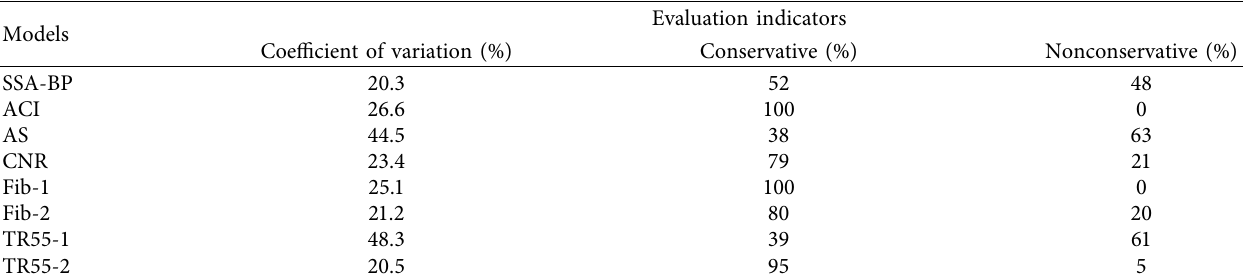
Figure 3: Comparison of the calculated values and real values. (a) SSA-BP. (b) ACI. (c) AS. (d) CNR. (e) fib-1. (f) fib-2. (g) TR55-1. (h) TR55-2. Table 2: Performance of the